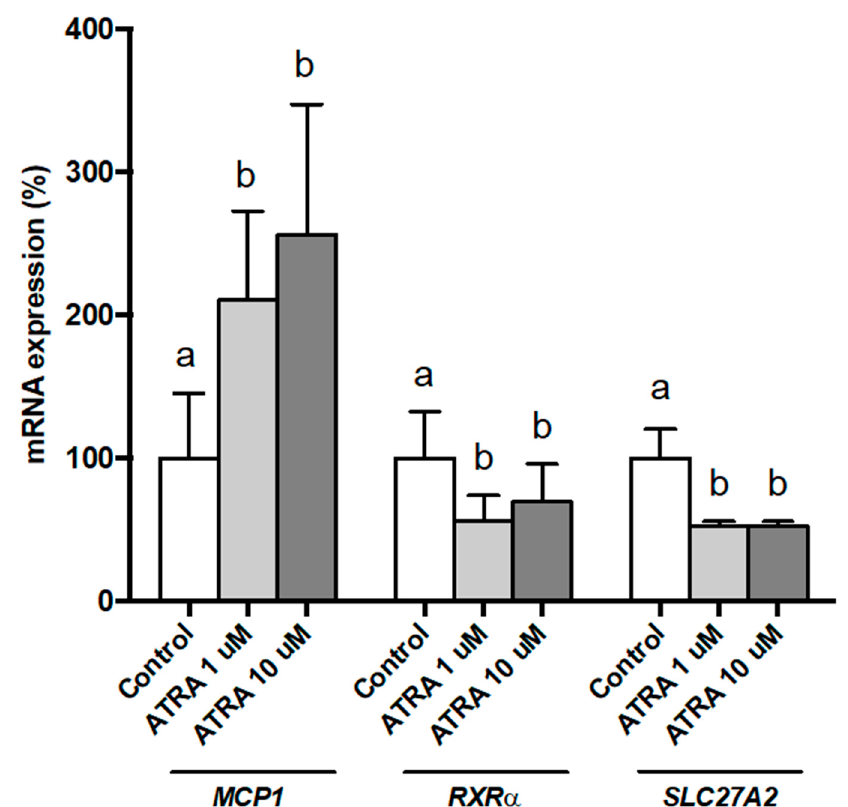
Figure 1. Dose e ff ects of all-trans retinoic acid (ATRA) on MCP1 , RXR α , and SLC27A2 expression in human PBMCs from selected normal-weight (NW) individuals, measured by real-time RT-qPCR. PBMCs were treated for 48 h with vehicle control (ethanol) or ATRA at various concentrations in the presence of CD3 / CD28 magnetic beads. mRNA levels were normalized to RPLP0 and expressed relative to vehicle-treated cells. Data represent means ± SEM (3 replicates). One-way repeated measures ANOVA was performed followed by least significant di ff erence (LSD) post-hoc test. Data not sharing a common letter (a,b) are significantly di ff erent ( p <